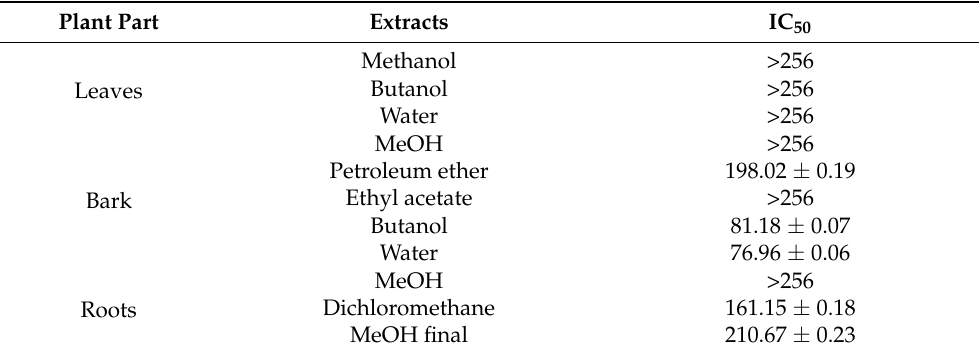
Table 4. Toxicity (IC 50 in µ g/ mL) of the most effective fractions on MRC 5 cell lines with comparison to the raw extract (n = 3). Plant Part Extracts IC 50 Methanol >256 Butanol >256 Leaves Water >256 MeOH >256 Petroleum ether 198.02 ± 0.19 Ethyl acetate >256 Bark Butanol MeOH >256 Dichloromethane 161.15 ± Roots